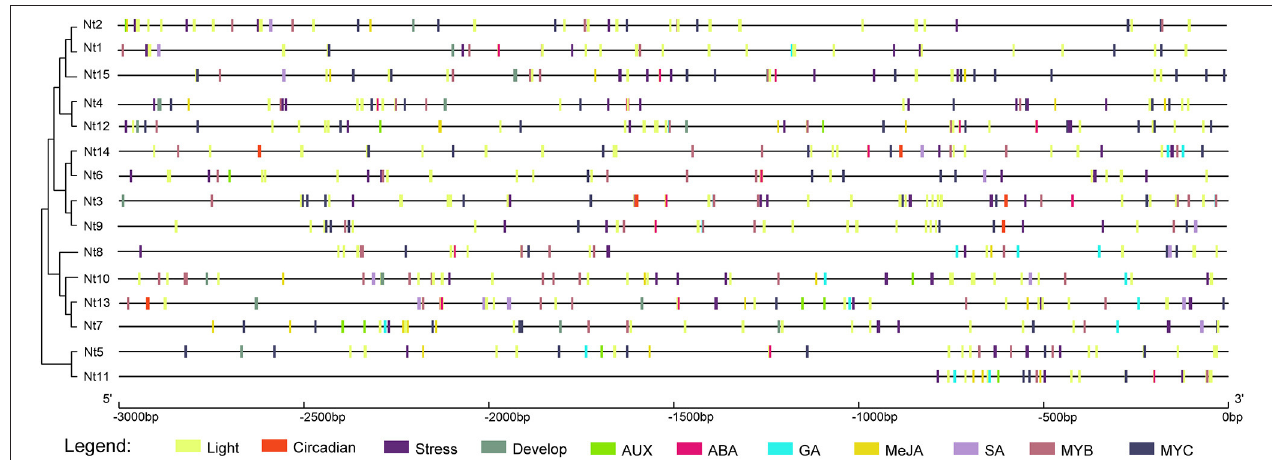
nucleus and merged with DAPI. These results suggested that fusion proteins were specifically localized in the